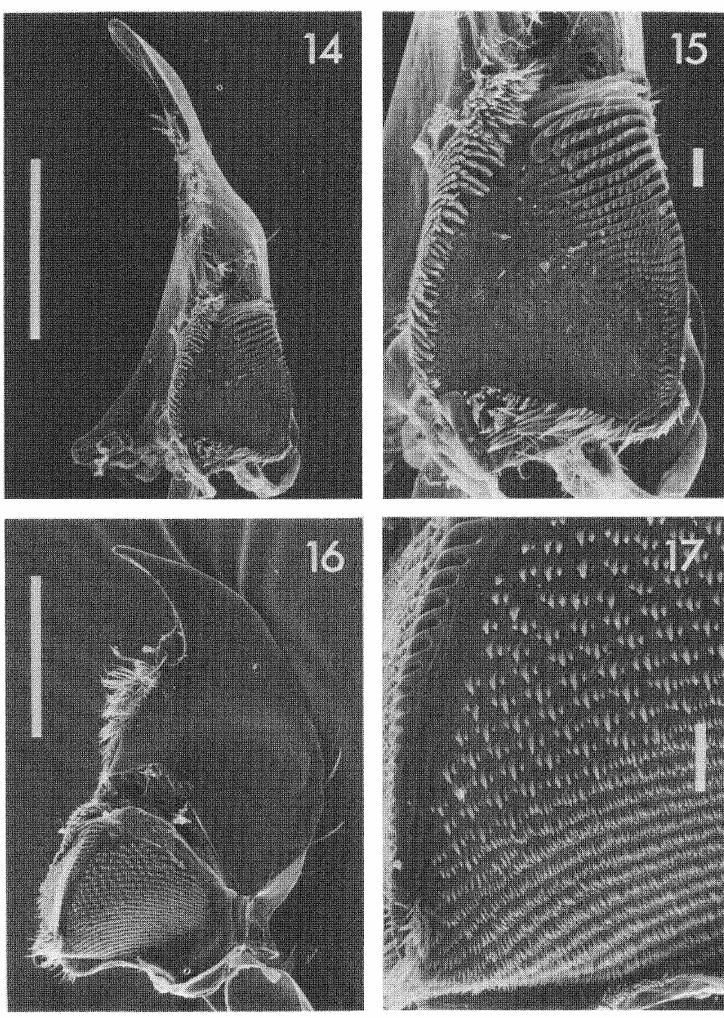
Figs. 14-17. Glypholoma pustuliferum, right mandible. 14-15. Mesal view, whole mandible and molar surface, respectively. 16-17. Dorsal view, whole mandible and part of mola, respectively. Scale lines: figs. 14, 16 0.1 mm; figs. 15, 17 0.01